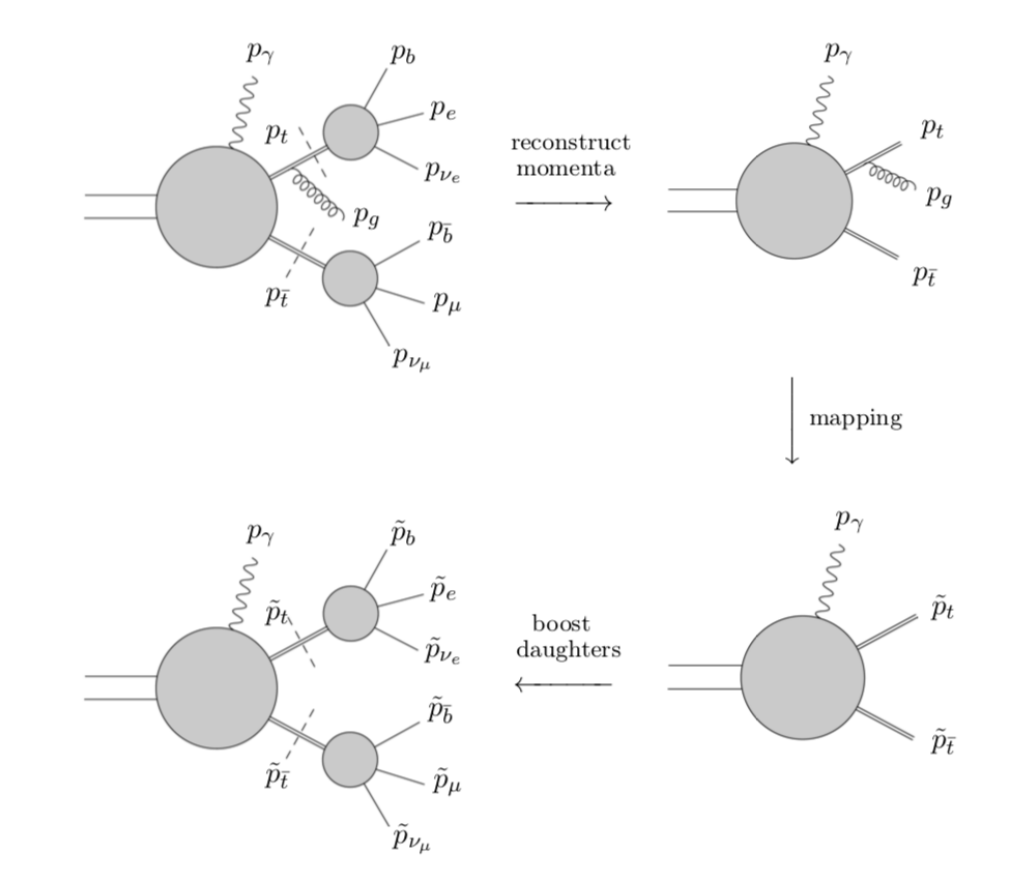
Figure 3 . The phase-space mapping as applied to an intermediate emitter. The shown example refers to the case where the emitter is the top quark and the spectator is the anti-top